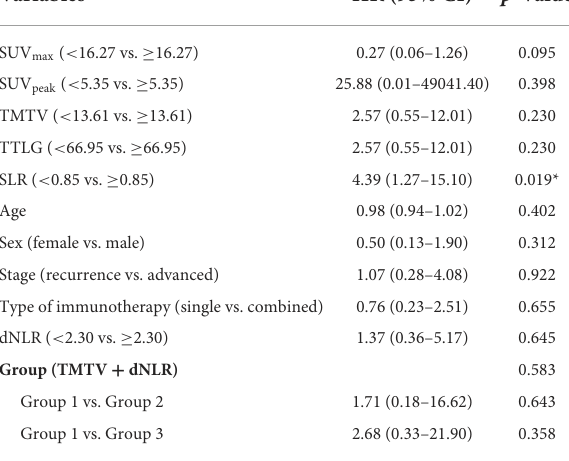
TABLE 4 Univariable analysis for OS by Cox proportional hazard